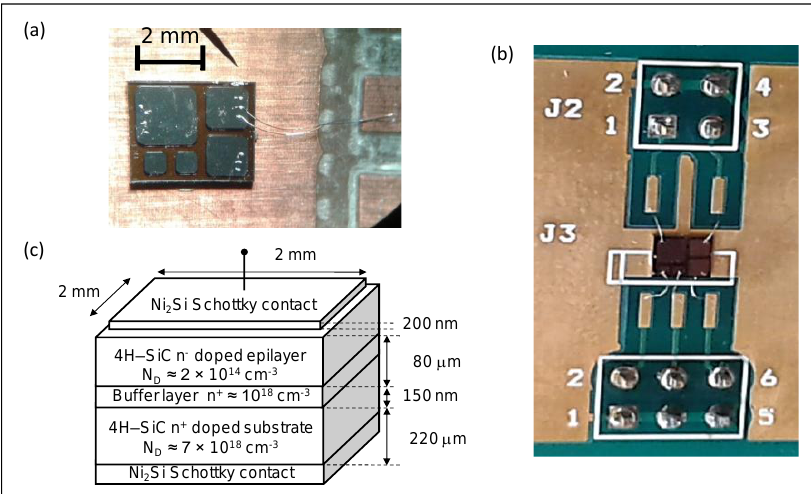
Figure 1. Photo of the SiC detector employed, the larger one of the five reported ( a ); holder of the SiC detectors ( b ); and scheme of the SiC diode employed in this experiment ( c ).